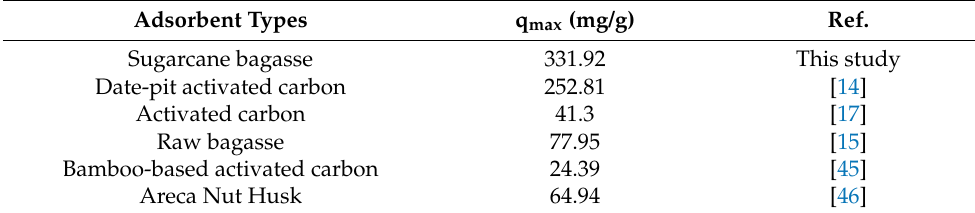
Table 6. Comparison of the q max of COD removal by various